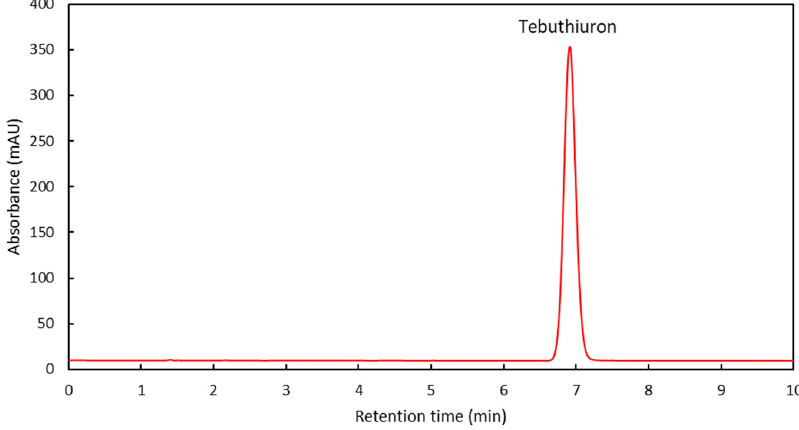
Figure 2. A typical HPLC chromatogram of a Regain extract, with the location of the tebuthiuron peak peak indicated.